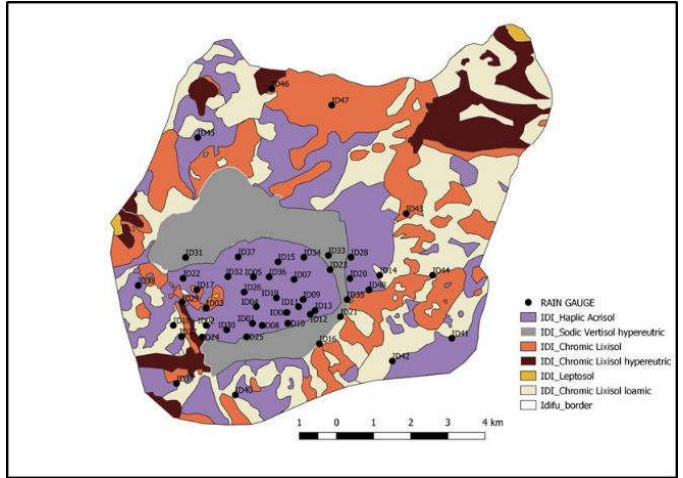
Figure 2. Soil pattern and rain gauge positions at the Idifu study site.